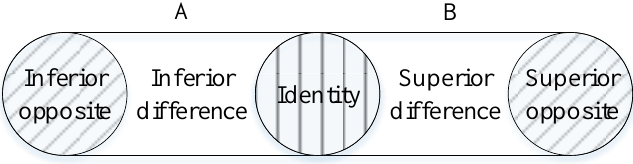
Figure 2. Five grades of connection degrees of two sets.